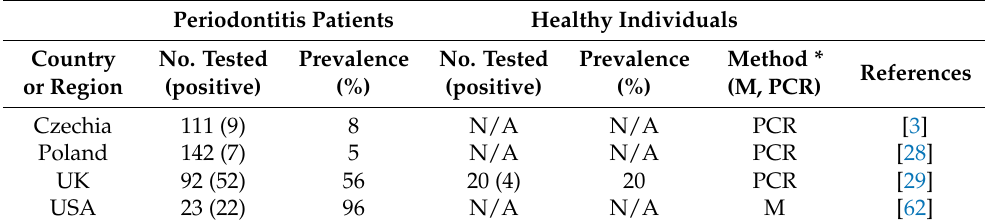
Table 5. Prevalence of Trichomonas tenax in a domestic dog with or without